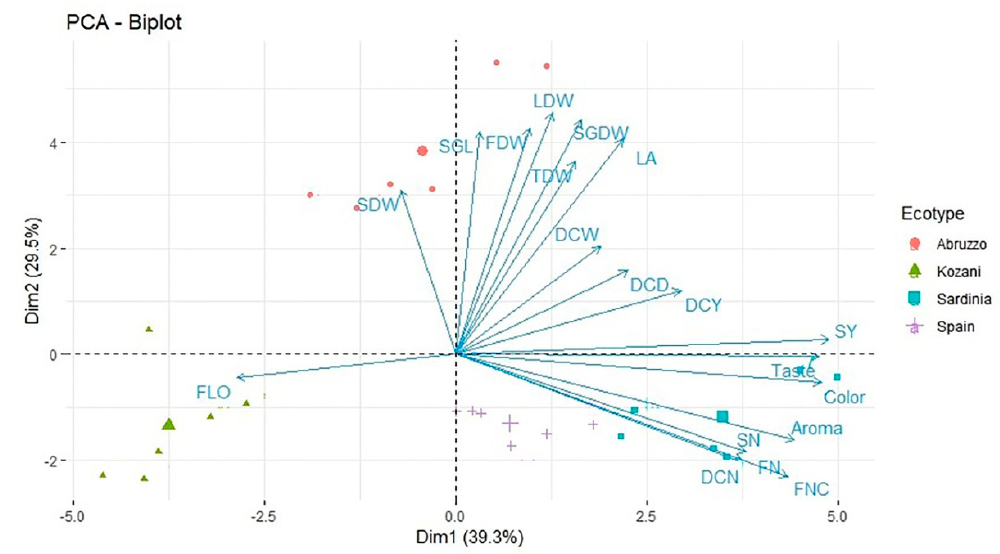
Figure 3. Biplot showing the projection from the analysis of phenological, morpho-productive, and qualitative traits.